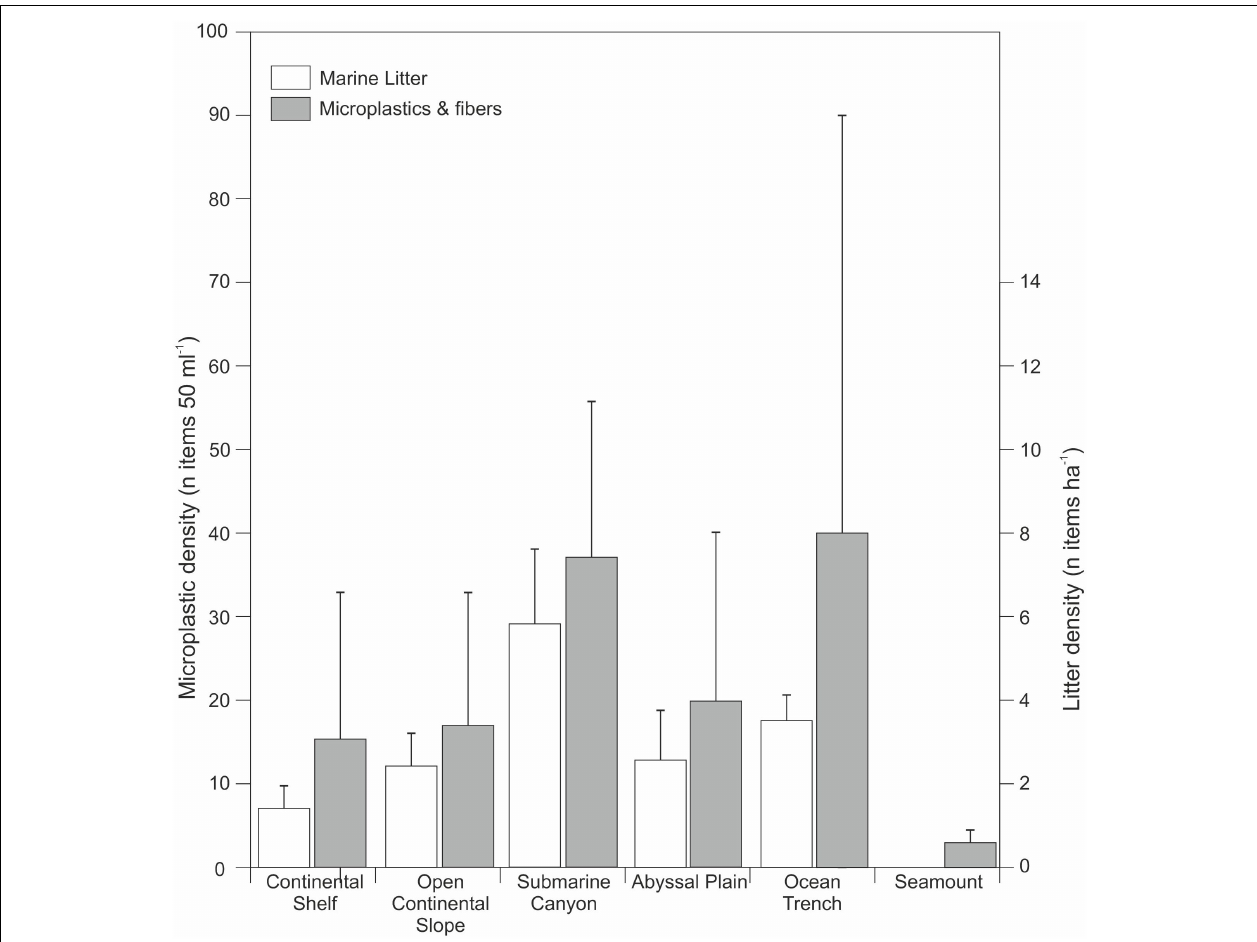
FIGURE 4 | Compilation of microplastic and microfiber distribution in deep-marine sediments and their gross depositional environments (data compiled from: Van Cauwenberghe et al., 2013; Woodall et al., 2014; Fischer et al., 2015; Bergmann et al., 2017; Graca et al., 2017; Leslie et al., 2017; Martin et al., 2017; Peng et al., 2018; Sanchez-Vidal et al., 2018; Kanhai et al., 2019). As a comparison data from marine litter distributions collected by Pham et al. (2014) are